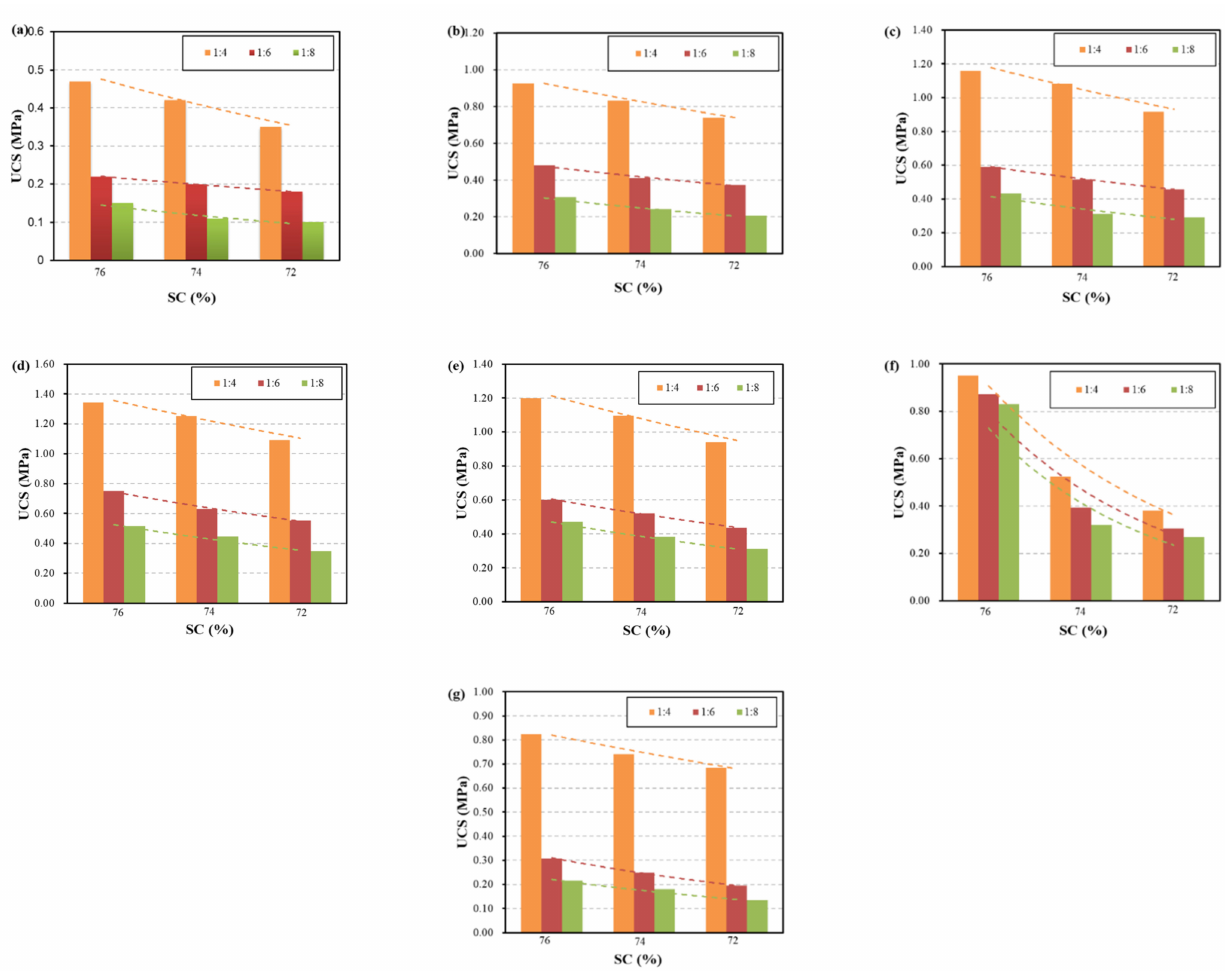
Figure 9. Relationships between the SC and UCS of FCPB with various Ts and FCs. ( a ) T = 3 d, FC = 1.5%; ( b ) T = 7 d, FC = 1.5%; ( c ) T = 14 d, FC = 1.5%; ( d ) T = 28 d, FC = 1.5%; ( e ) T = 28 d, FC = 2%; ( f ) T = 28 d, FC = 2.5%; and ( g ) T = 28 d, FC =